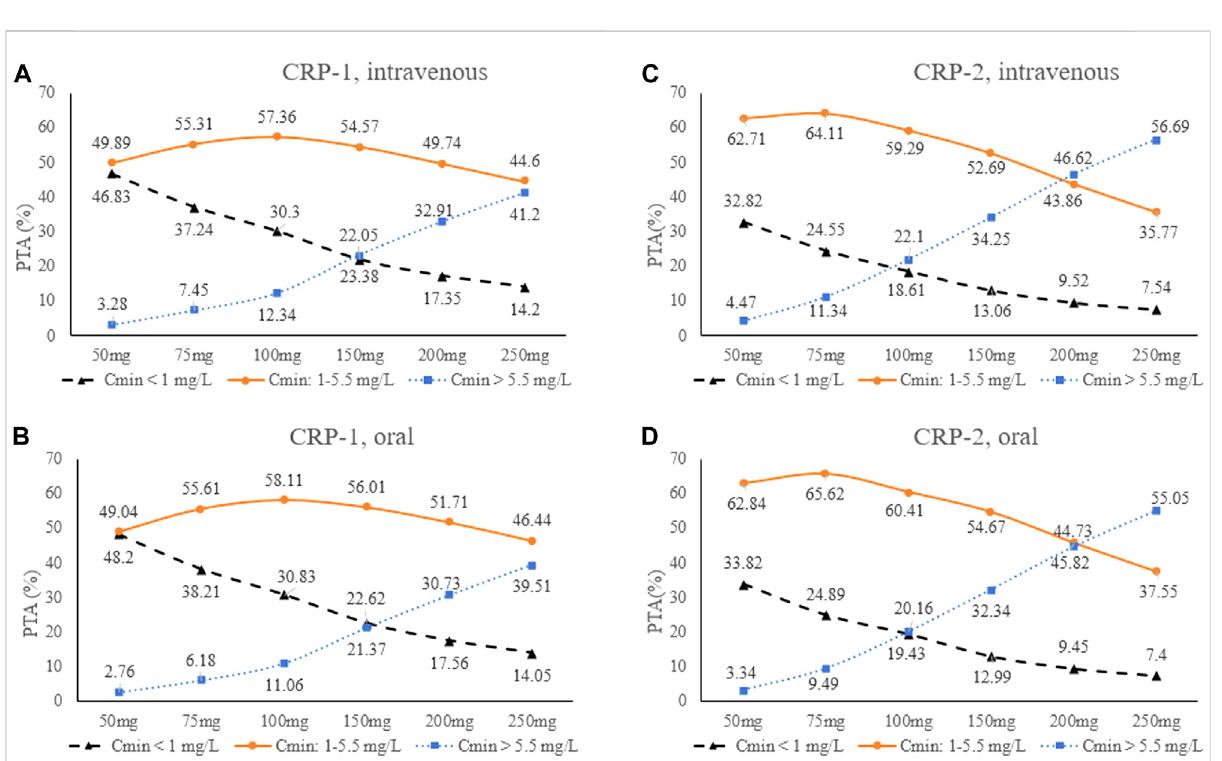
200 mg/12 h, i.v.